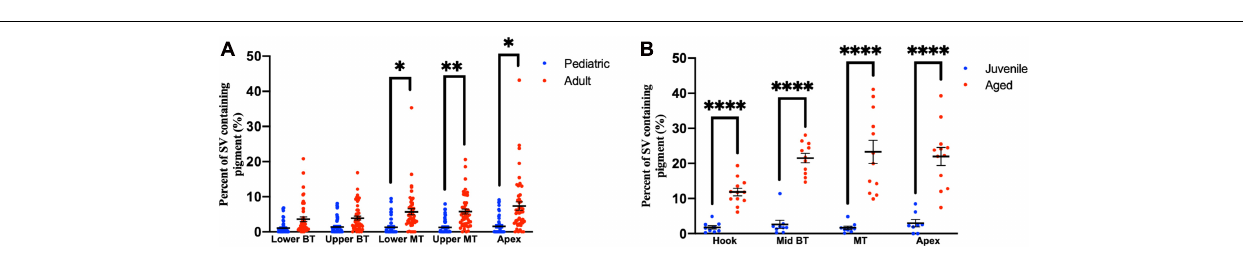
Frontiers in Neuroscience |